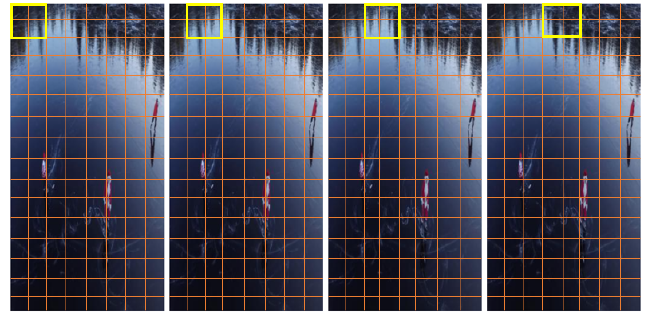
Figure 8. Creating